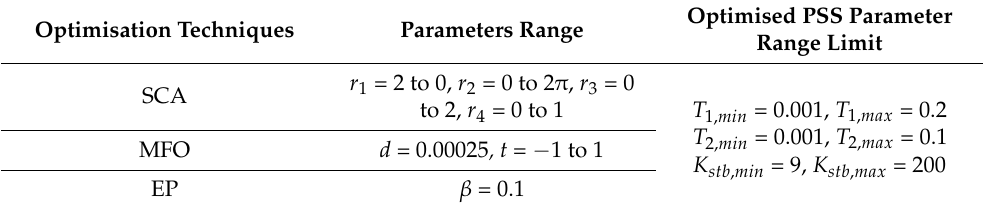
Table 6. Parameters for optimisation